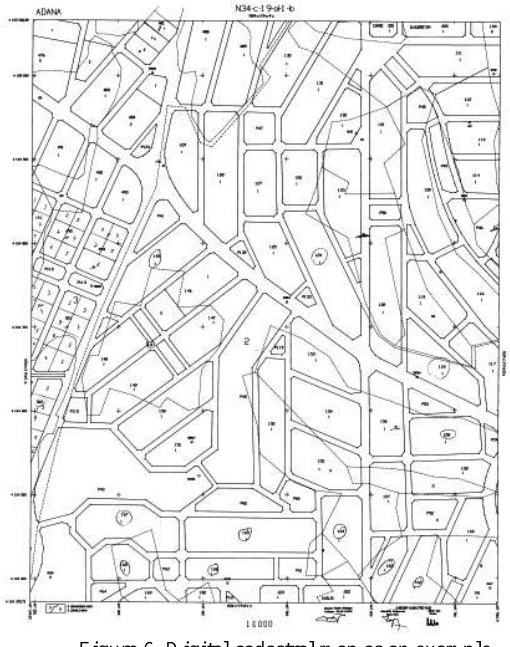
Figure 6. Digital cadastral map as an example In the regions having more than one LOSC, LOSCs with a large burden of tax and employment have financial problems because of competitive among LOSCs and extremely price-cutting. In that situation some architectures and engineers in construction financial